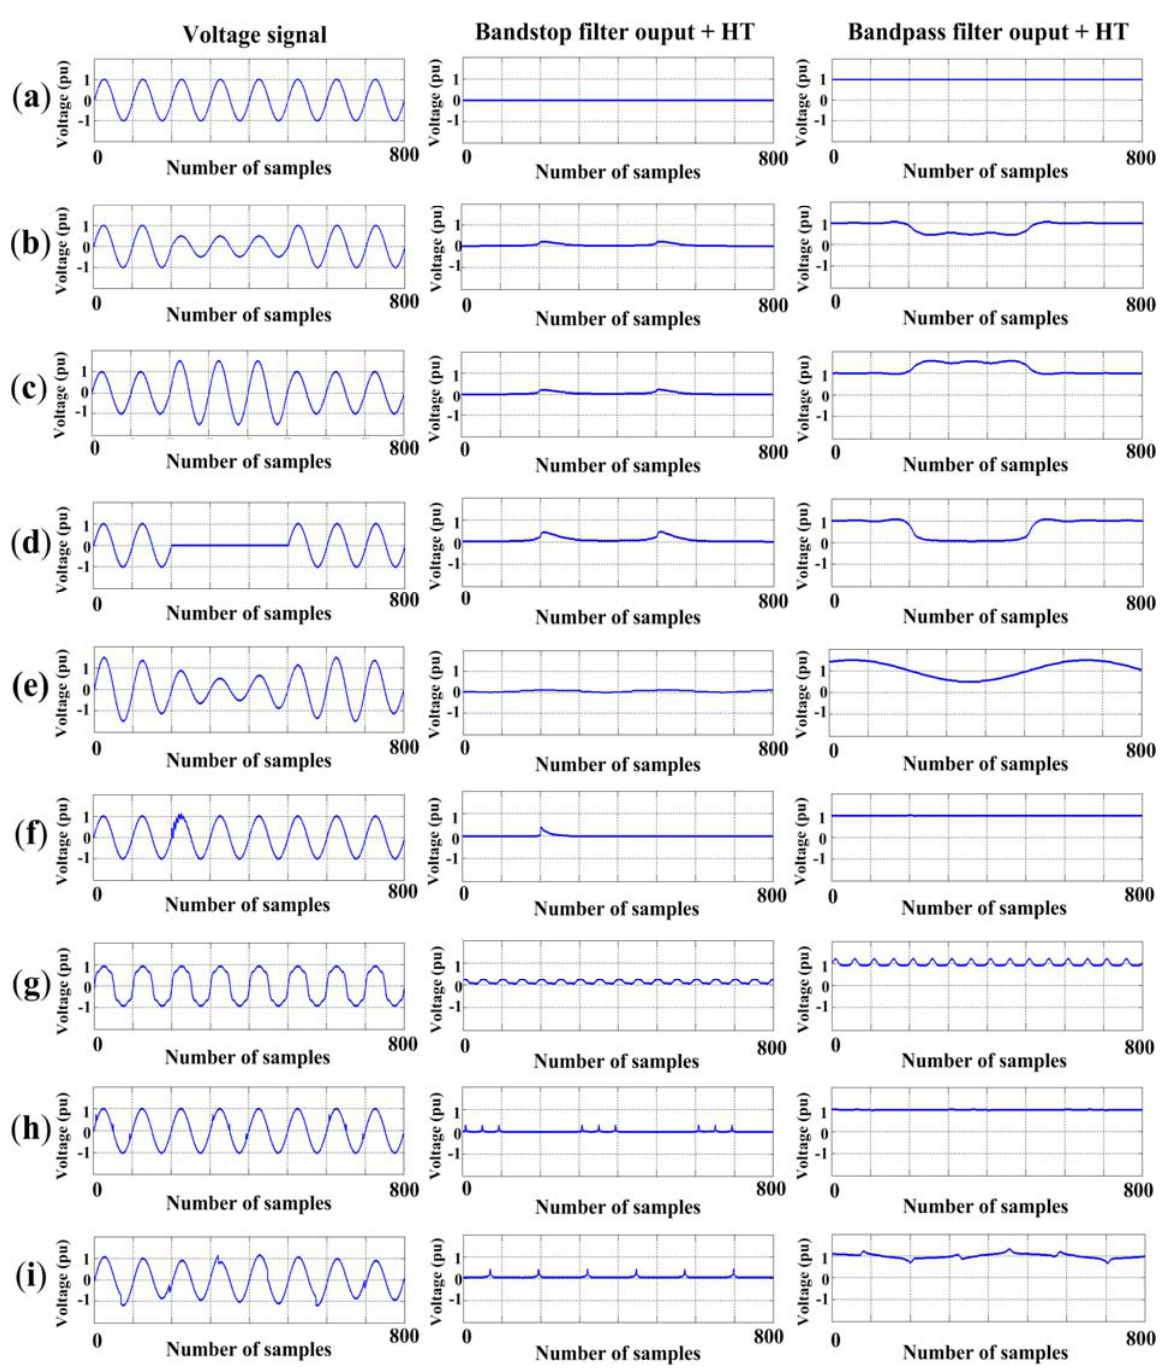
Figure 7. PQD generated. ( a ) Pure signal; ( b ) Sag; ( c ) Swell; ( d ) Interruption; ( e ) Flicker; ( f ) Transients; ( g ) Harmonics; ( h ) Notching; ( i )